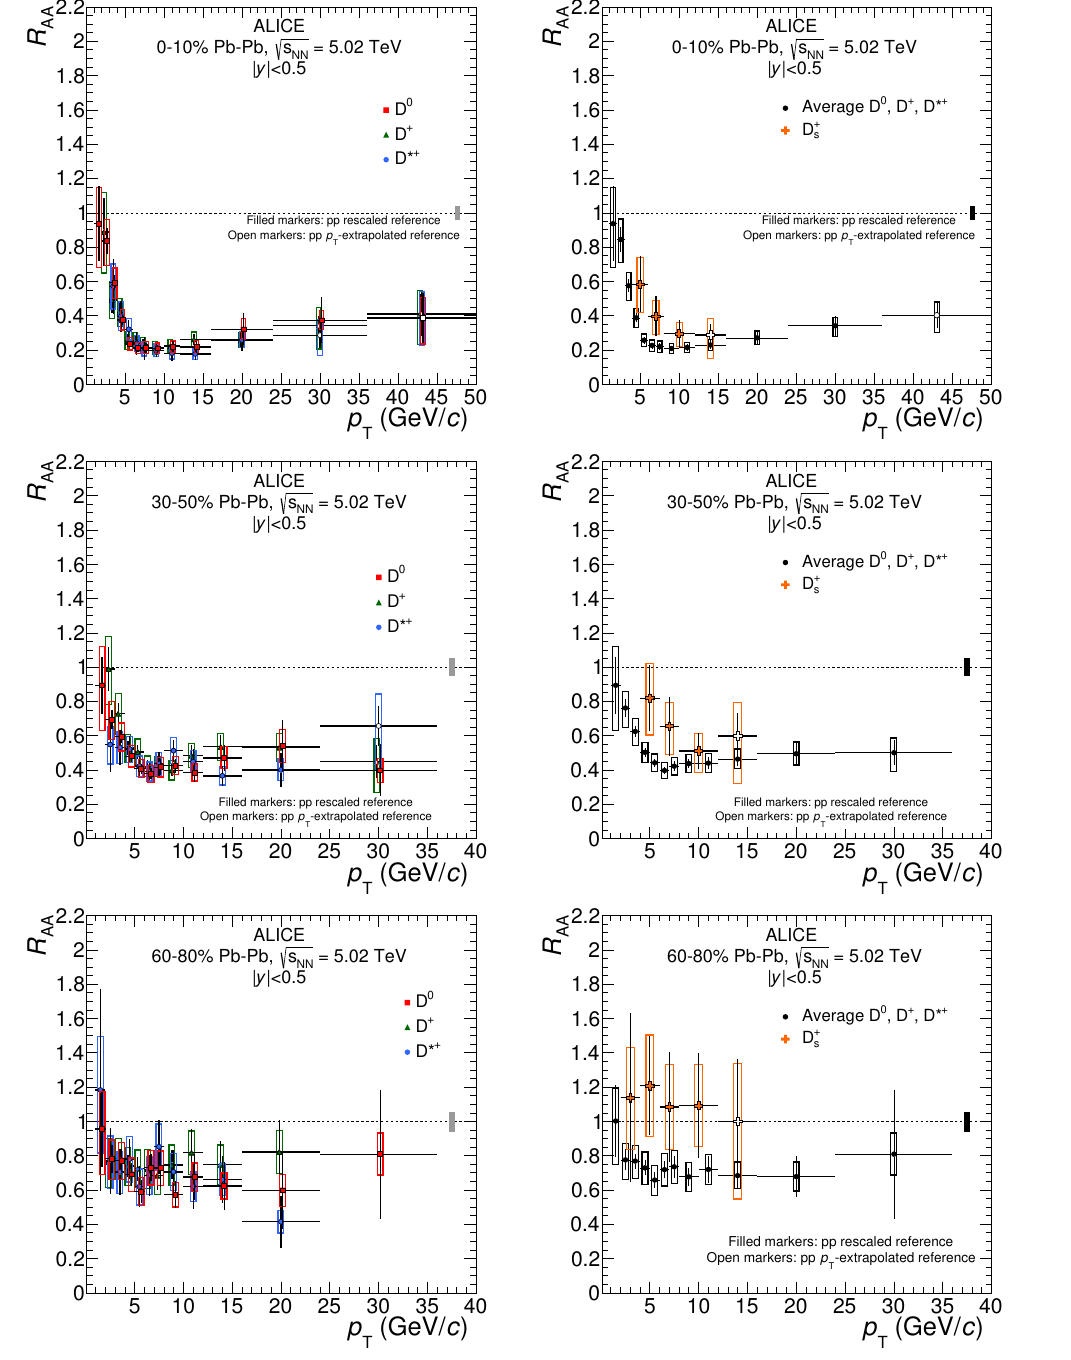
Figure 5 . R AA of prompt D 0 , D + and D (cid:3) + mesons (left-hand panels) and of prompt D + compared with the average R AA of the non-strange D-meson states available in each p T inter- val (right-hand panels) for the 0{10%, 30{50% and 60{80% centrality classes. Statistical (bars), systematic (empty boxes), and normalisation (shaded box around unity) uncertainties are shown. Filled markers are obtained with the pp rescaled reference, empty markers with the p T -rescaled reference.